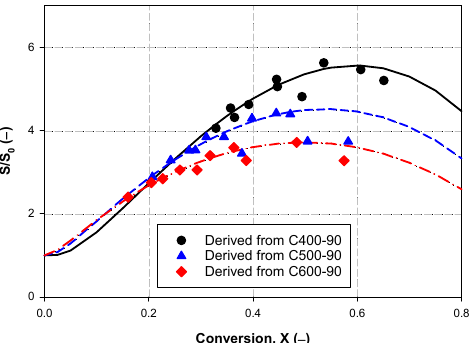
Figure 13. The development of reaction surface with conversion according to the RPM. The activated carbon products were derived from chars carbonized at 400, 500 and 600 ◦ C for 90 min, respectively. The black solid line, blue dash line and red dash-dot lines represent the predicted data derived from Equation (8). The black circles, blue triangles and red diamonds indicate the experimental data points .